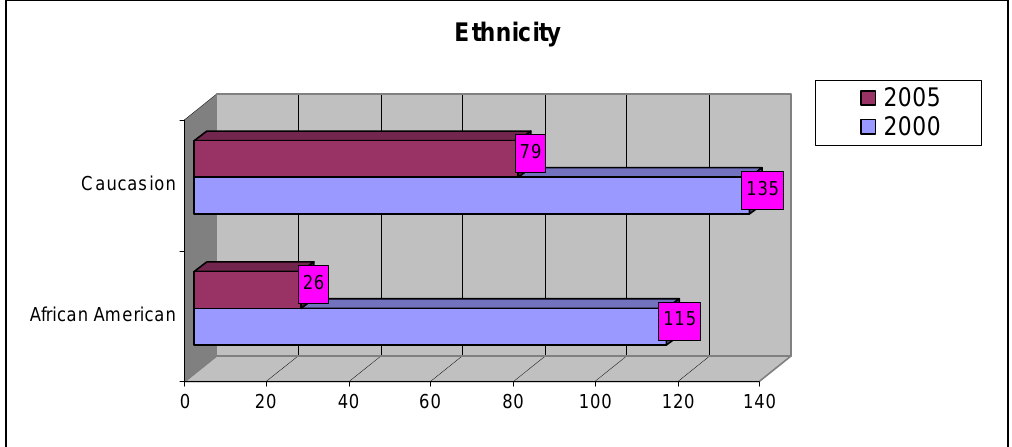
Disciplinary Action by